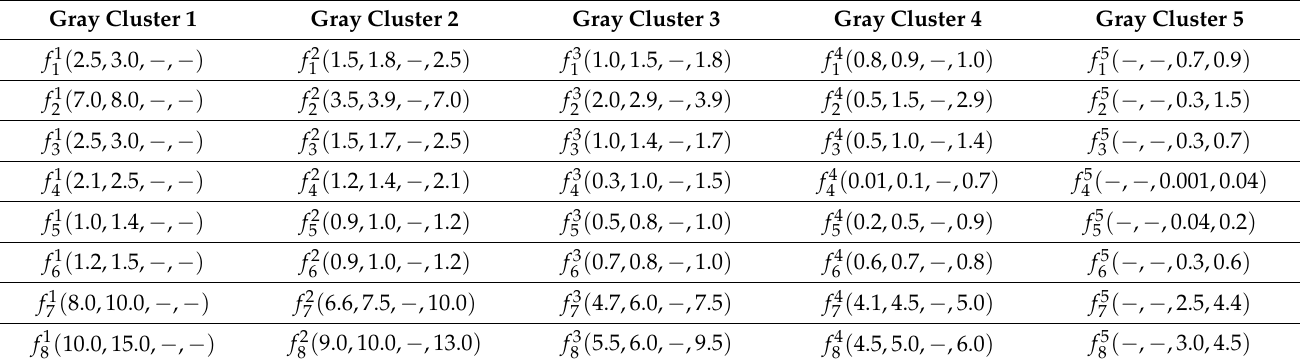
Table 4. The structure of the whitening weight function that each indicator corresponds with in